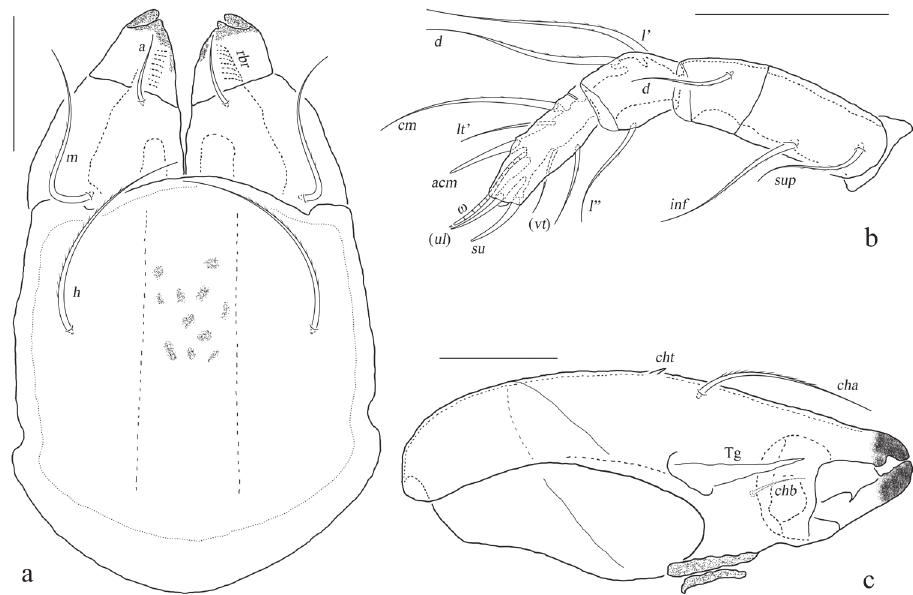
Figure 4. Basiceramerus ovatus sp. nov. adult: a subcapitulum, ventral view b left palp, abaxial view c left chelicera, adaxial view. Abbreviations and notations explained in text. Scale bars: 50